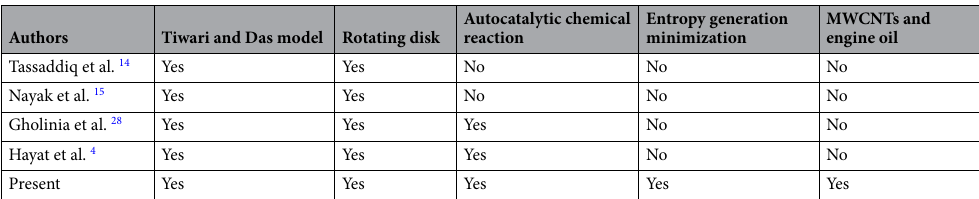
Table 1. Literature survey for inimitability of the existing